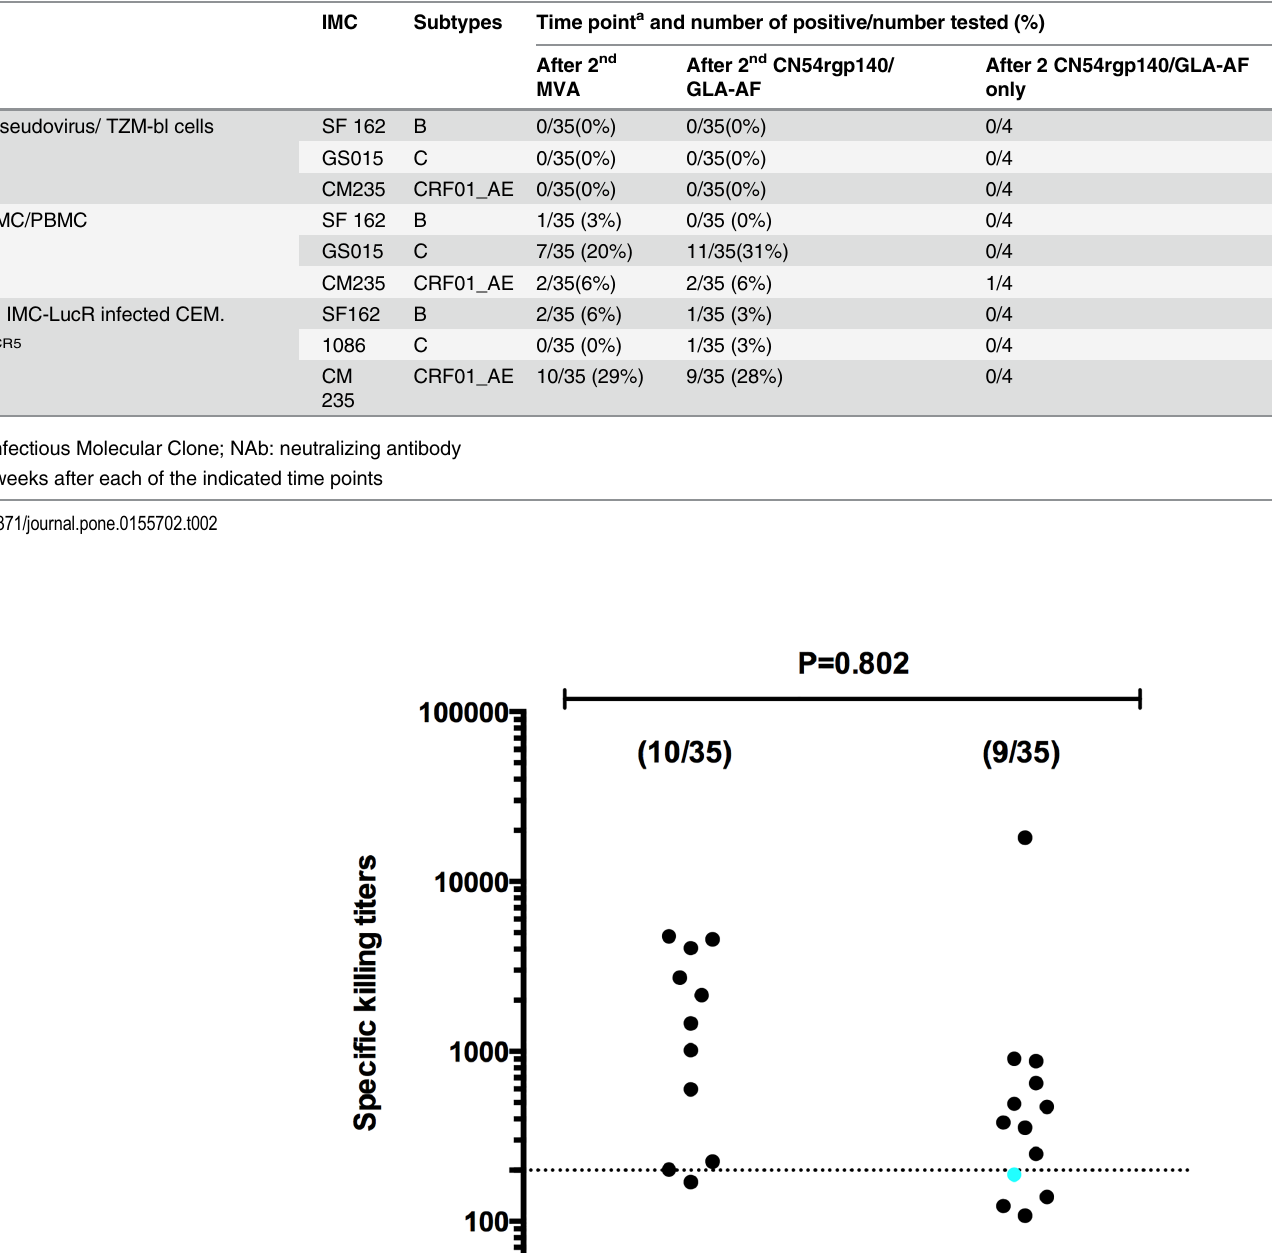
Table 2. Frequency of neutralization and ADCC antibody responses after the second HIV-MVA and after the second CN54rgp140/GLA-AF immunization. Assay IMC Subtypes Time point a and number of positive/number tested (%) NAb, pseudovirus/ TZM-bl cells